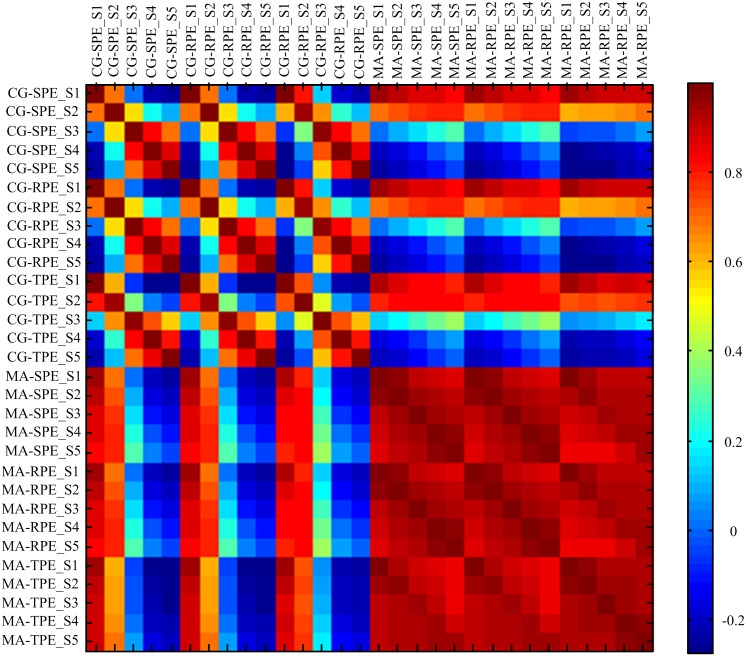
Correlation coefficient among six MSPE measures at five scales over 20 patients.